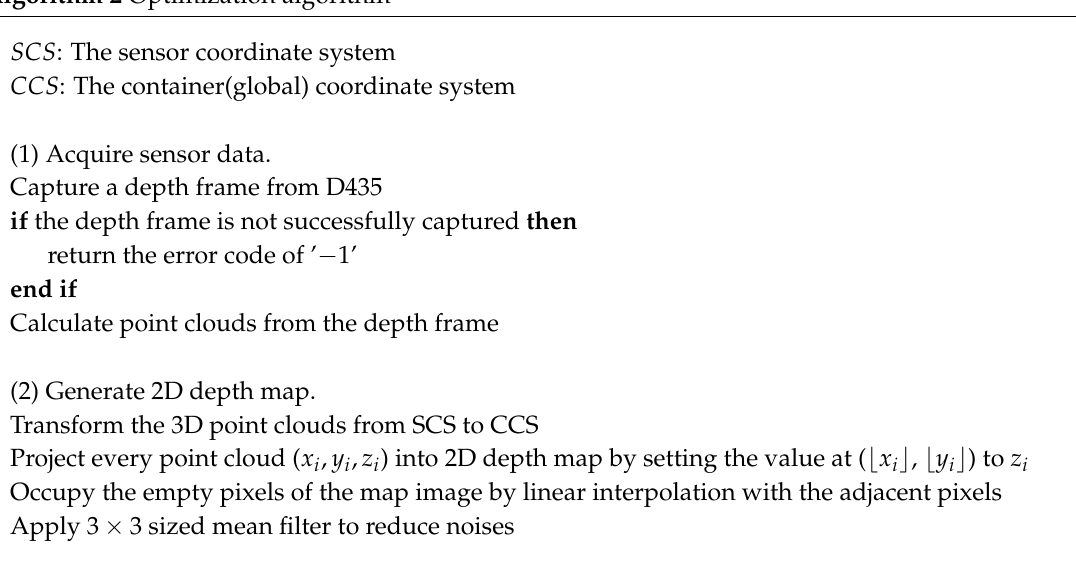
Algorithm 2 Optimization